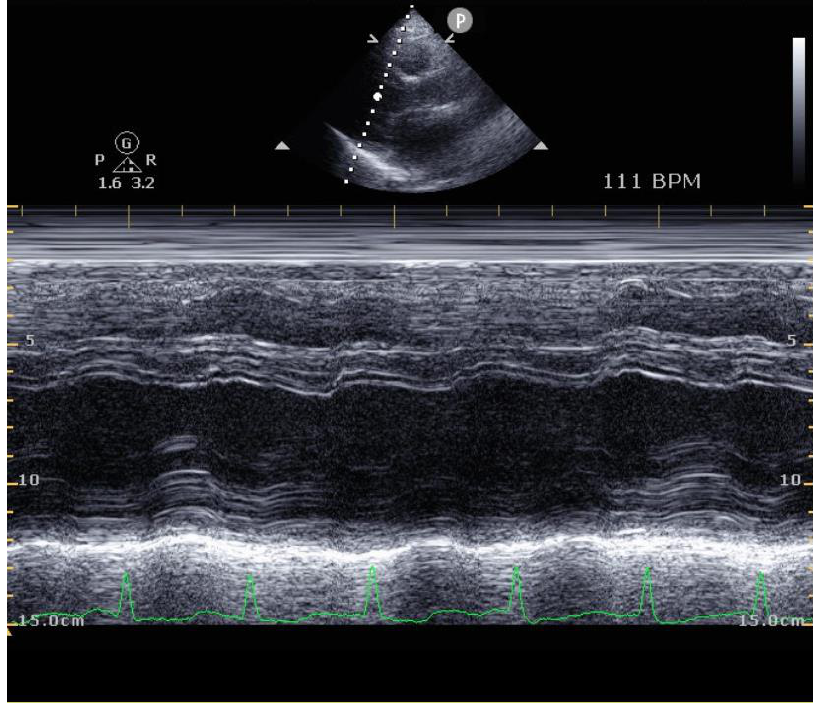
Figure 3. LVEDD and LVESD measured with the M-mode on parasternal long axis view. Abbreviations: LVESD, left ventricular end-systolic diameters; LVEDD, left ventricular end-diastolic diameters.